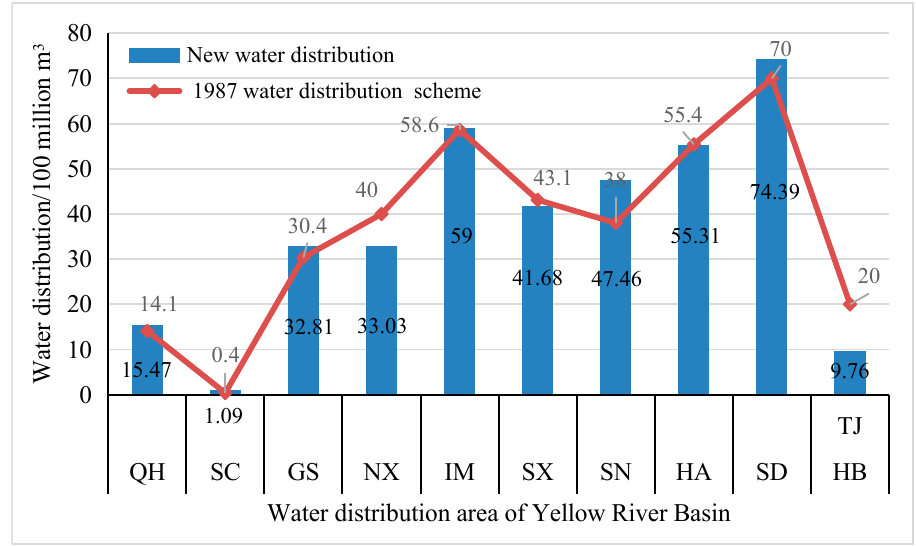
Figure 8. Comparison between the new water distribution scheme and the 1987 water distribution scheme.